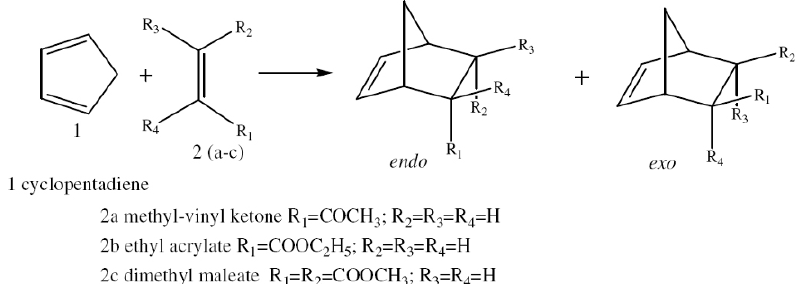
Figure 1. The Diels-Alder reaction between cyclopentadiene and various dienophiles: dimethyl maleate, methyl-vinyl ketone or ethyl acrylate in catalytic system, based on N-hexylpyridinium bis(trifluoromethylsulfonium) imide and Y, Yb, Mg, Zn chlorides or